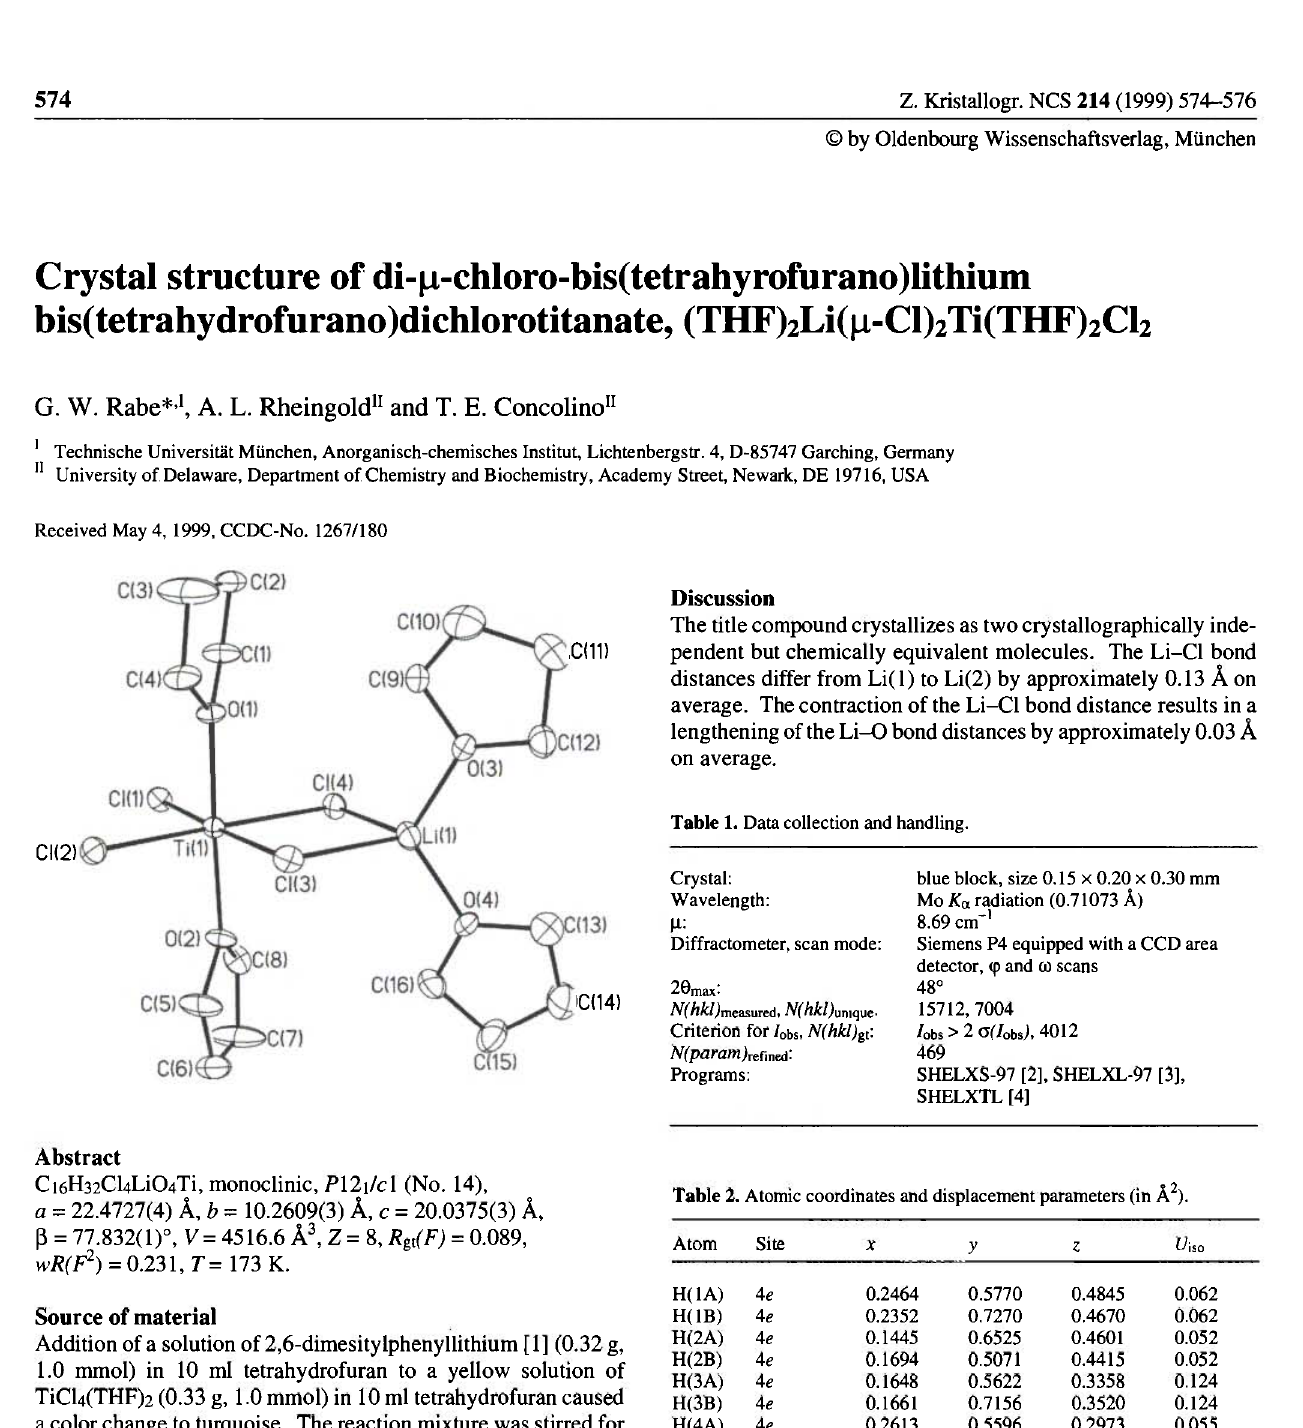
Table 2. Atomic coordinates and displacement parameters (in Ä 2